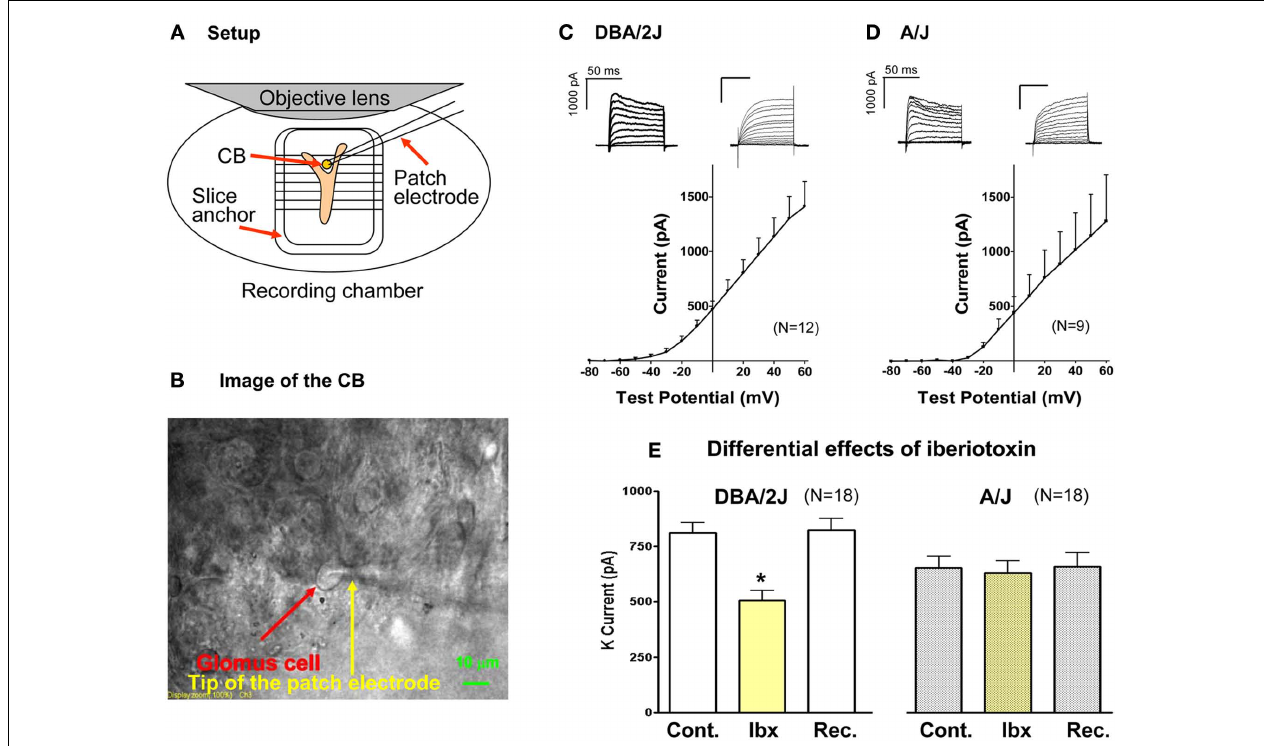
The effect of iberiotoxin (a BK channel blocker; 200nM) on outward current in GCs.The outward current was evoked by a test pulse from − 80 to + 20mV for 100ms. Iberiotoxin significantly and reversibly decreased outward current in GCs of the DBA/2J mice. However, K current in the A/J mice was not significantly affected by iberiotoxin. ∗ , Significantly different from control and recovery.The amplitudes of K current (control and recovery) were significantly larger in GCs of the DBA/2J mice. Cont, control; Ibx, iberiotoxin; Rec,